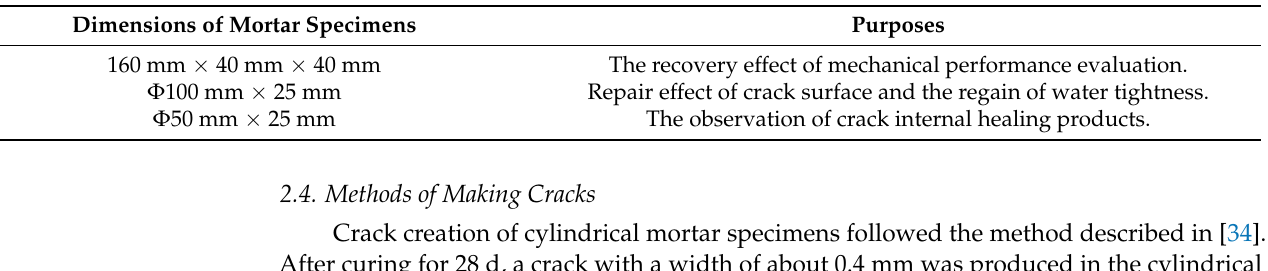
Table 2. Dimensions and purposes of each specimen.